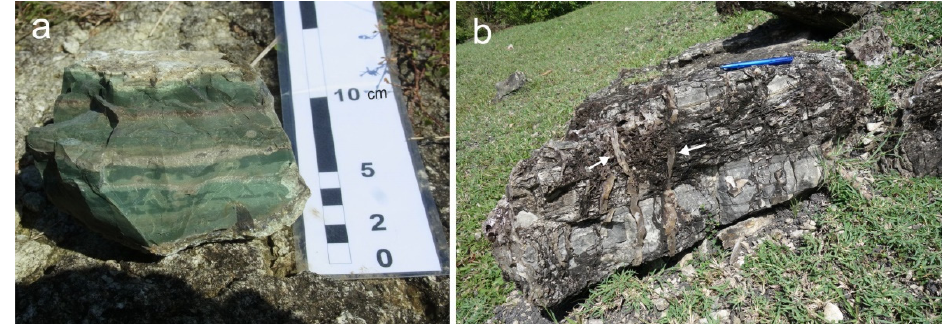
Figure 2. ( a ) A layered and strongly altered tuff and ( b ) a brecciated volcanic host rock with secondary quartz and chalcedony veins (arrows) from El Picado, Cuba.